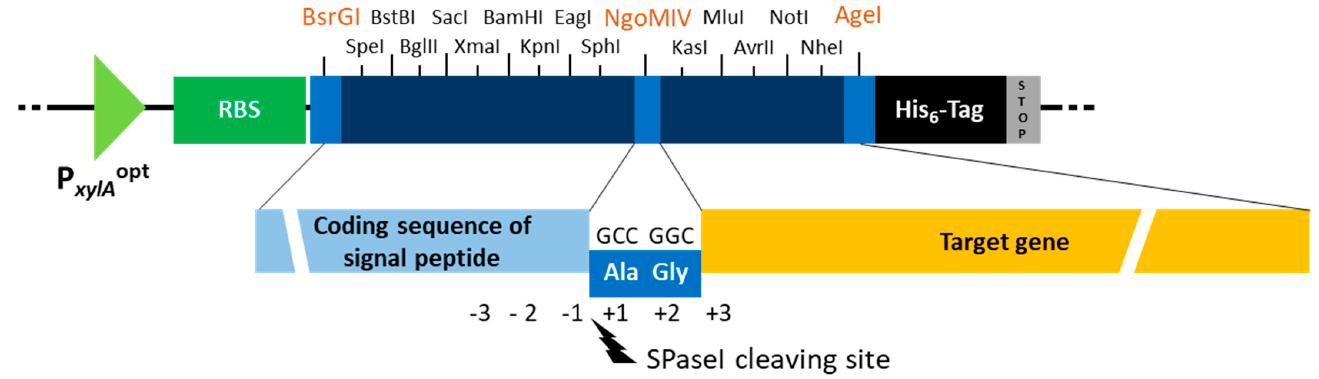
Figure 1. Schematic representation of the molecular components of the plasmid-based SP test system in P. megaterium based on the plasmid pTKSP0. The SP coding sequences including their appropriate native start codon can be cloned in the 5 (cid:48) part of the MCS, ideally using the BsrGI (5 (cid:48) ) and NgoMIV (3 (cid:48) ) sites. The target gene can be cloned in the 3 (cid:48) part of the MCS using the corresponding recognition sites optional as fusion to the His 6 -tag coding sequence. On the protein level, the inserted NgoMIV restriction site leads to the indicated additional alanine and glycine residues between SP and target protein, which now represent the +1 and +2 positions relative to the signal peptidase I (SPaseI) cleaving site. The SPaseI cleaving site is defined as position − 3, − 2, − 1 (last residues of the SP) and position +1 of the target protein. P xylA opt —optimized xylose inducible promoter; RBS—ribosome binding site.